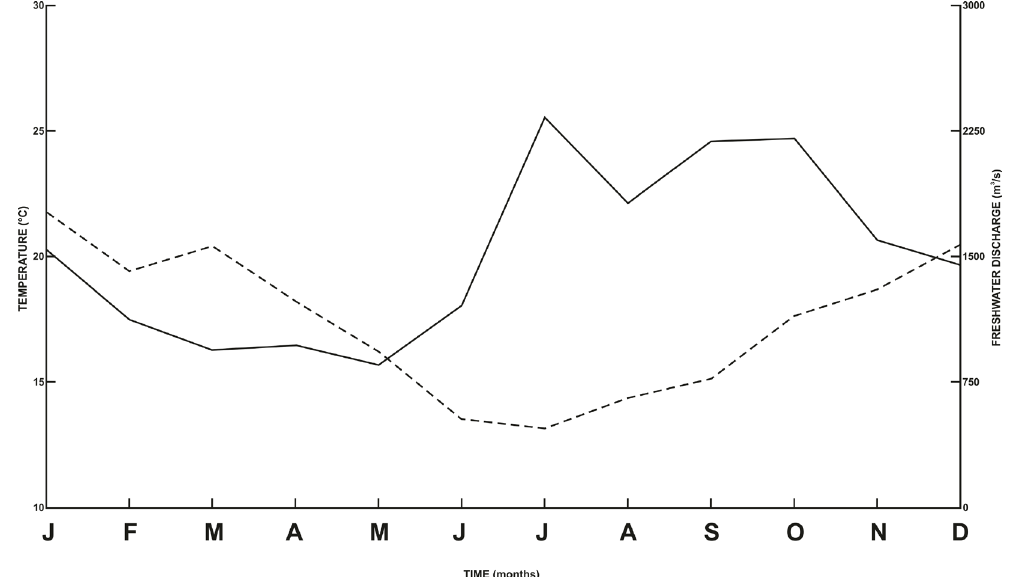
Figure 1 - Monthly average (grouped months) profiles of air temperatures (dashed line) and fluvial discharge (spatial rainfall average estimates; straight line) in the southernmost Brazilian coast throughout the sampling period of this study (January 2009-August